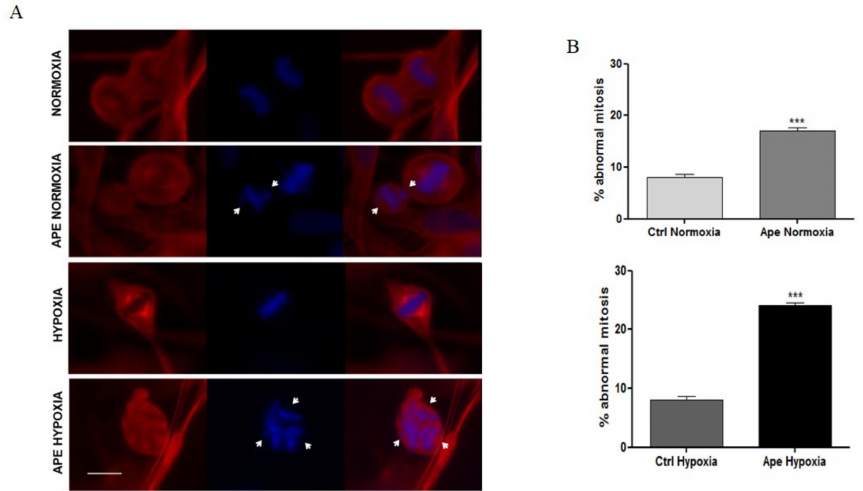
Figure 6. ( A ) Immunocytochemistry of the GB7 cells for α -tubulin (Red) in normoxia and hypoxia and in presence or absence of 100 µ M Ape (24 h). (DAPI) (Blue) was used for DNA and chromosome staining (scale bar = 5 µ m) ( B ) Percentage of abnormal mitosis measured in three independent experiments ( t -test; *** p <